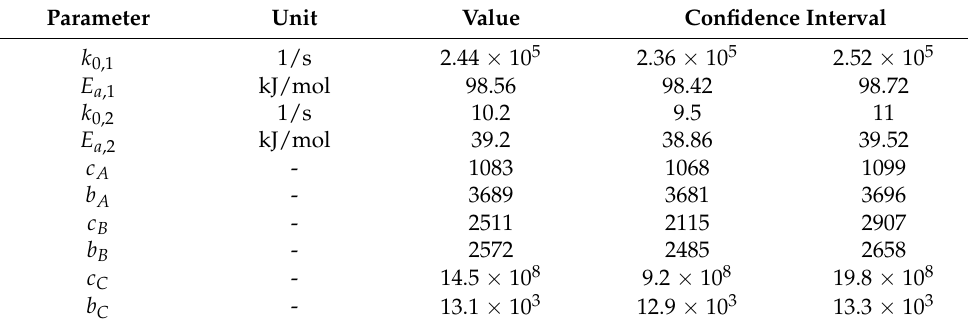
Table 1. Fitted parameter values and confidence intervals.